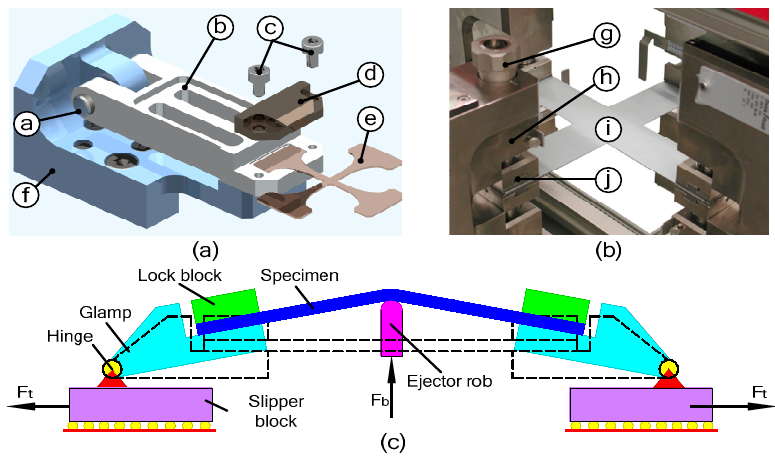
Figure 3. Clamping program for the specimen. ( a ) Schematic diagram for specimen clamping; ( b ) Loaded schematic of the clamping unit bender; ( c ) Clamping form of the existing commercial test apparatus. a (cid:13) Hinge; b (cid:13) Clamp; c (cid:13) Compression screw; d (cid:13) Lock block; e (cid:13) Specimen; f (cid:13) Slipper block; g (cid:13) Compression screw; h (cid:13) Clamp; i (cid:13) Specimen; j (cid:13) Lock